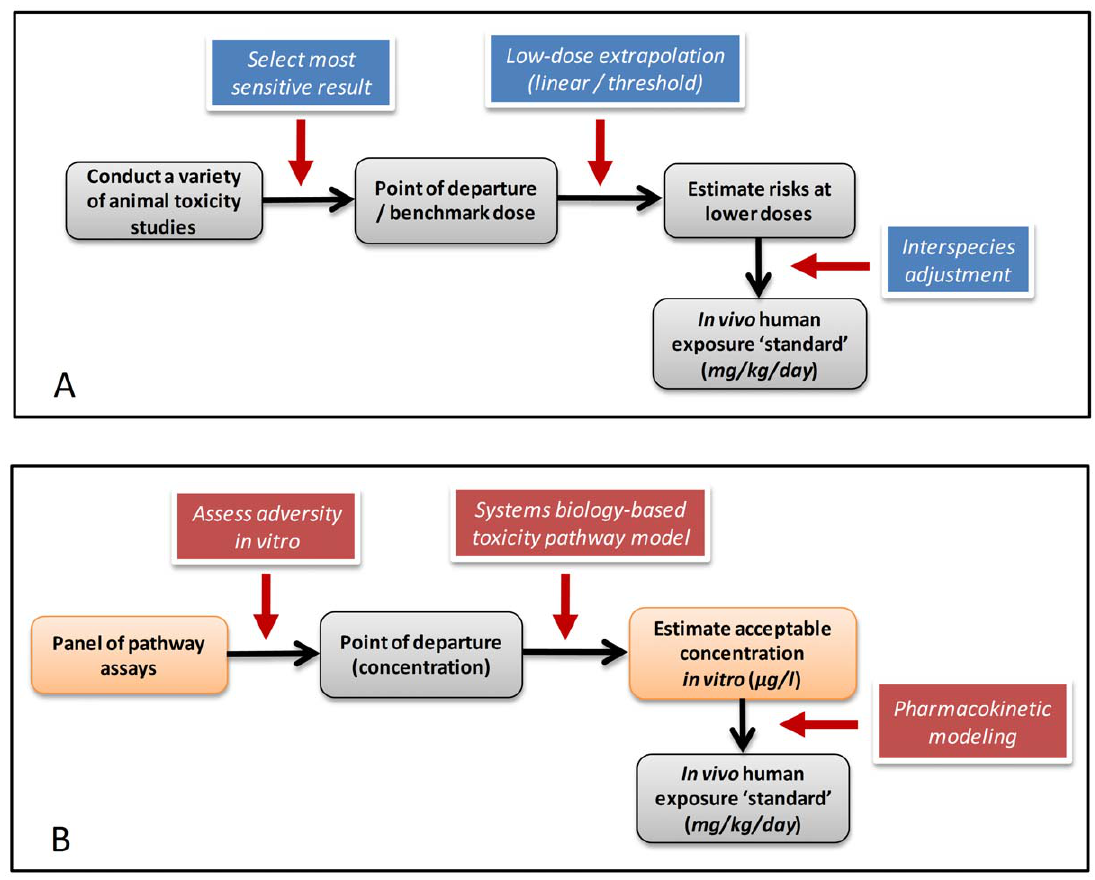
Figure 2. Comparison of current (A) and proposed (B) toxicity testing paradigms. The current approach (Panel A) to setting regulatory standards involves interpretation of the most sensitive end point observed in animal studies. Low-dose extrapolation requires obtaining a point of departure from the results of the animal studies and the use of either linear or threshold extrapolation plus application of uncertainty factors to the point of departure. Other extrapolations between species or across exposure routes are sometime conducted with pharmacokinetic modeling of the tissue doses that are associated with adverse effects. A similar sequence of steps can be envisioned for setting standards based on pathway assays (Panel B). Likely hazards are determined by the sensitivity of the various toxicity pathway assays; extrapolations require assessing adverse consequences of in vitro exposures and use of computational systems biology pathway (CSBP) and pharmacokinetic modeling to set a standard for human exposure related to mg/kg/day ingested or ppm (parts per million) in the inhaled air.